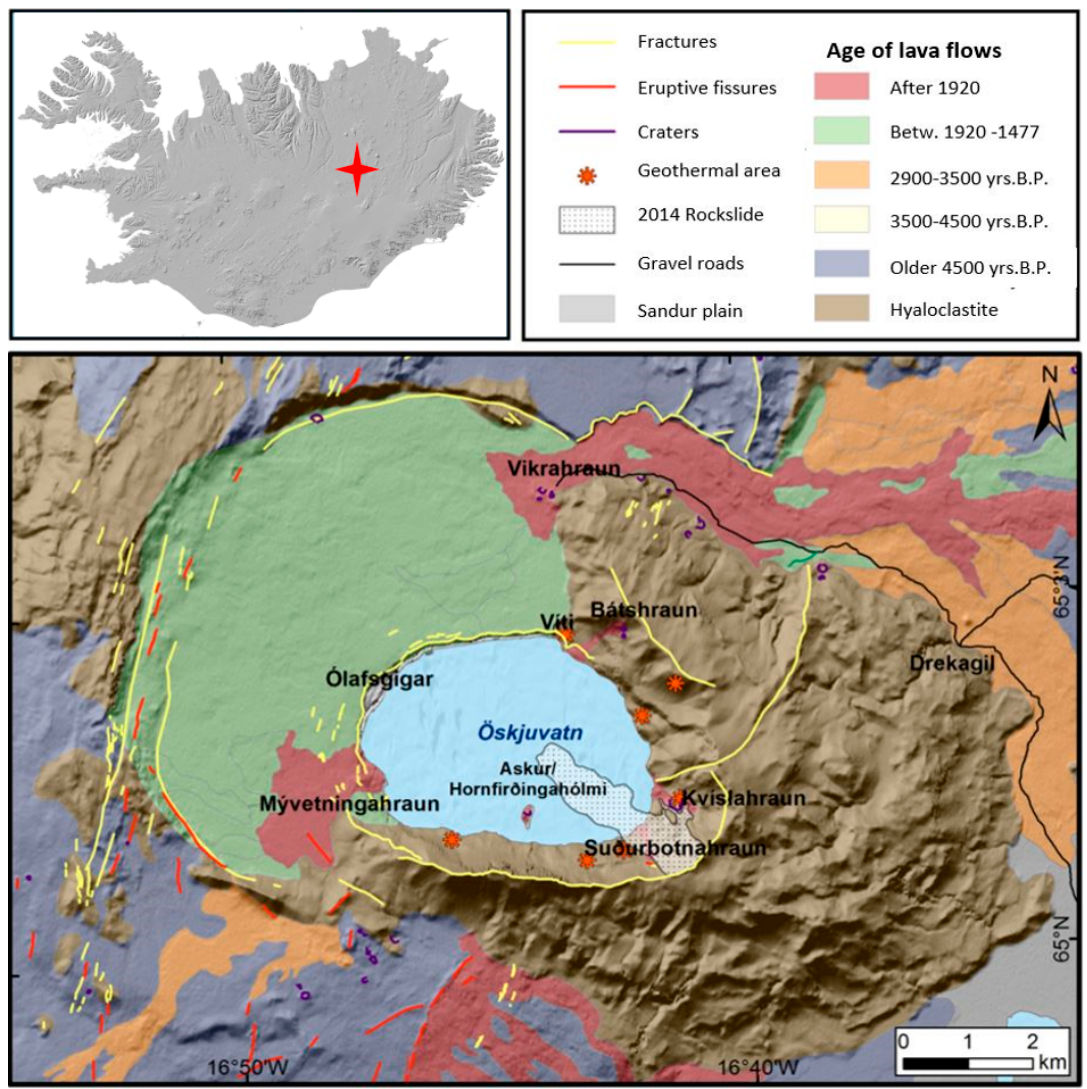
Figure 6. Overview map of the Askja area in the central highlands of Iceland (Modified after [59]).